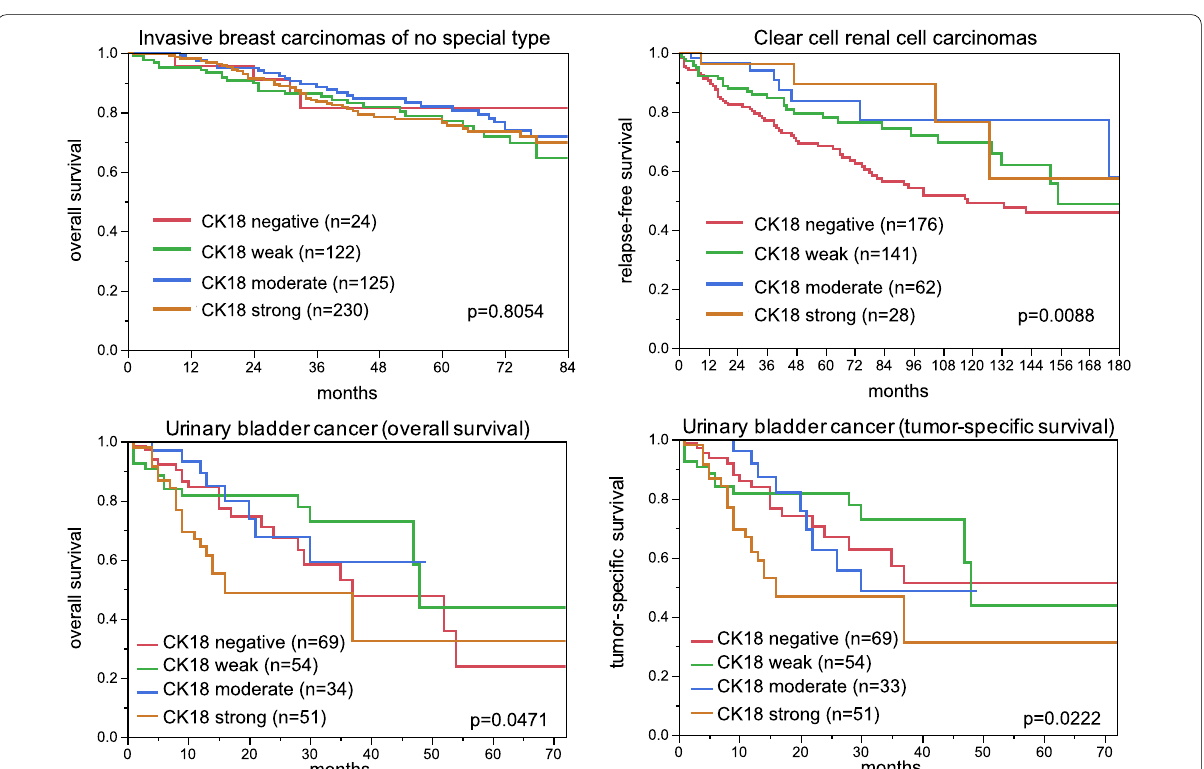
Fig. 4 Cytokeratin 18 (CK18) immunostaining and patient prognosis. All bladder cancer patients had at least pT2 cancers and were treated by